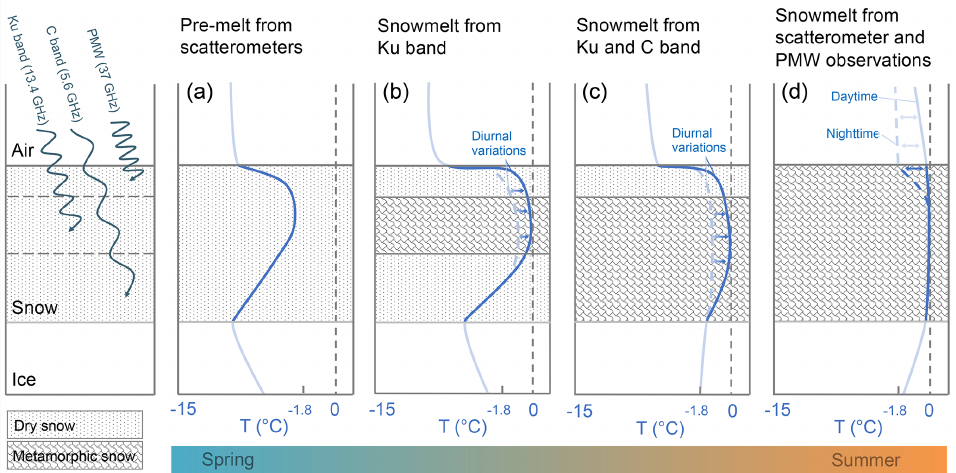
Figure 10. Conceptual model of the evolution of vertical air and snow and sea-ice temperature profiles, as well as snow metamorphism processes in the Antarctic sea-ice regime during spring and summer in four characteristic stages (a–d) . Note that snow temperatures close to 0 ◦ C lead to the appearance of liquid water and strong snow metamorphism. Diurnal thaw–freeze cycles during the stages shown in (b– d) cause significant differences in the snowpack properties and air temperatures between day- and nighttime. Microwaves with different wavelengths are sensitive to changing snow properties at different depths (left panel) and therefore indicate different melt onset dates in the same